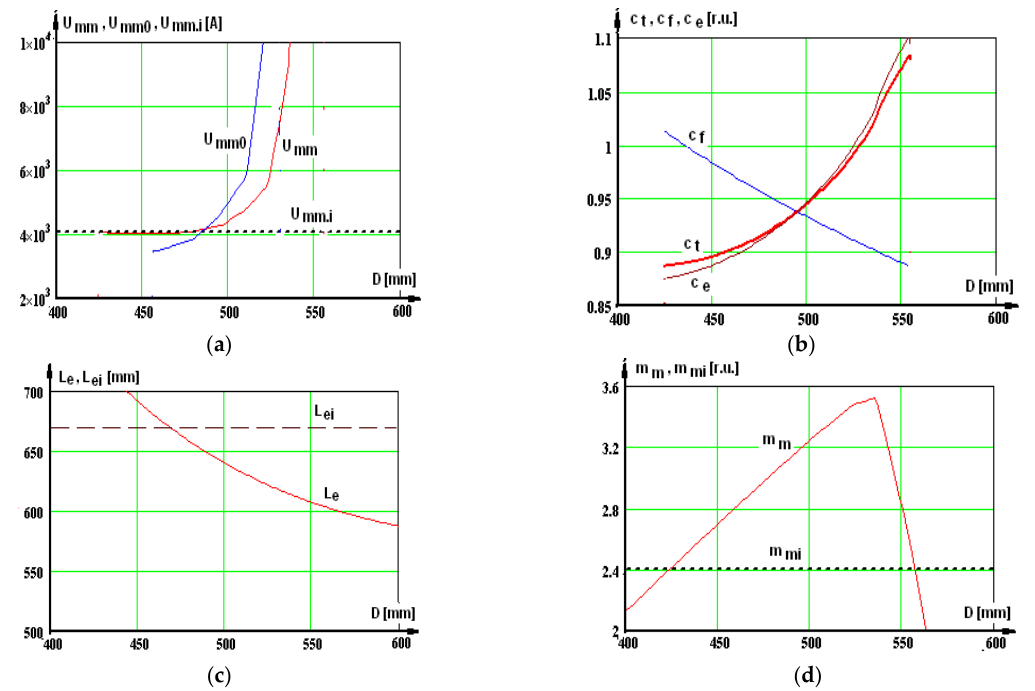
Figure 3. Variation curves relative to the variable D —machine diameter for: ( a ) total ampere-turn for a pole pair U mm 0 / U mm / U mm.i —for the optimized/real machine/imposed value; ( b ) c t / c f / c e —total/fabrication/exploitation cost; ( c ) total length; and ( d ) maximum torque. The optimization results relative to the analyzed variable D are shown in Table 1.